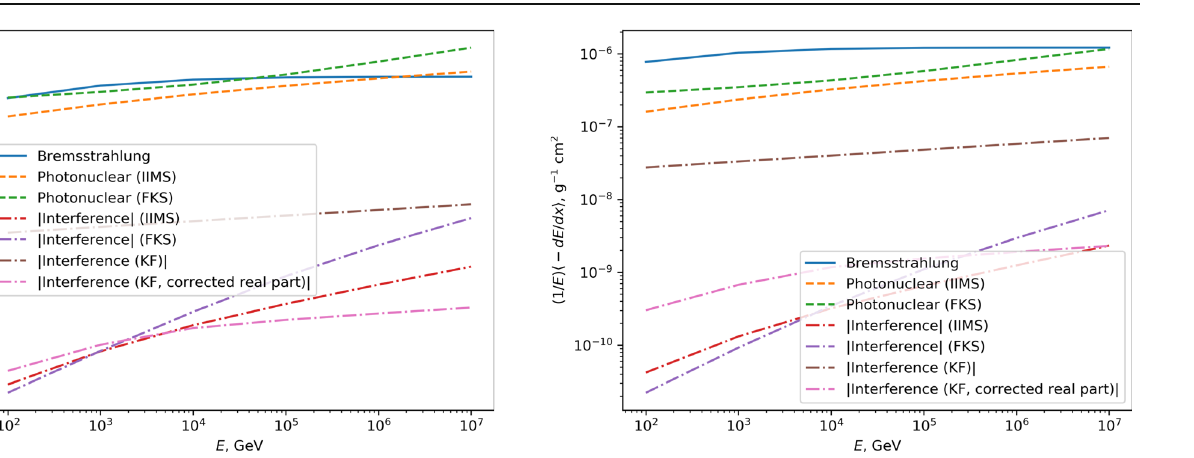
Fig. 2 Bremsstrahlung, photonuclear, and interference energy loss of muons on protons